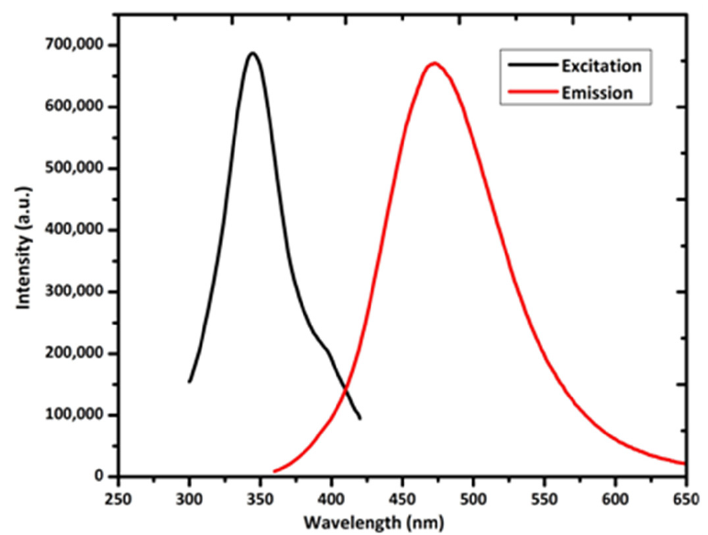
Figure 5. Excitation and emission spectrum of CQDs.